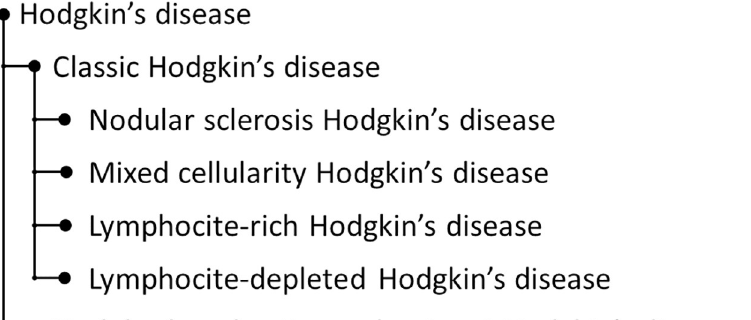
Fig 2. Hodgkin’s disease